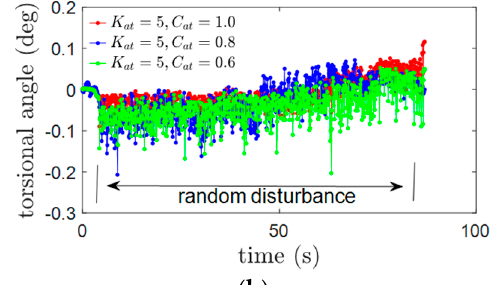
Figure 11. The torsional angles of the 5 − DoF MSMW with different types of disturbances. ( a ) The torsional angles of the flywheel rotor suffering the impulse disturbance with different damping coefficients; ( b ) The torsional angles of the flywheel rotor suffering the random disturbance with different damping coefficients.